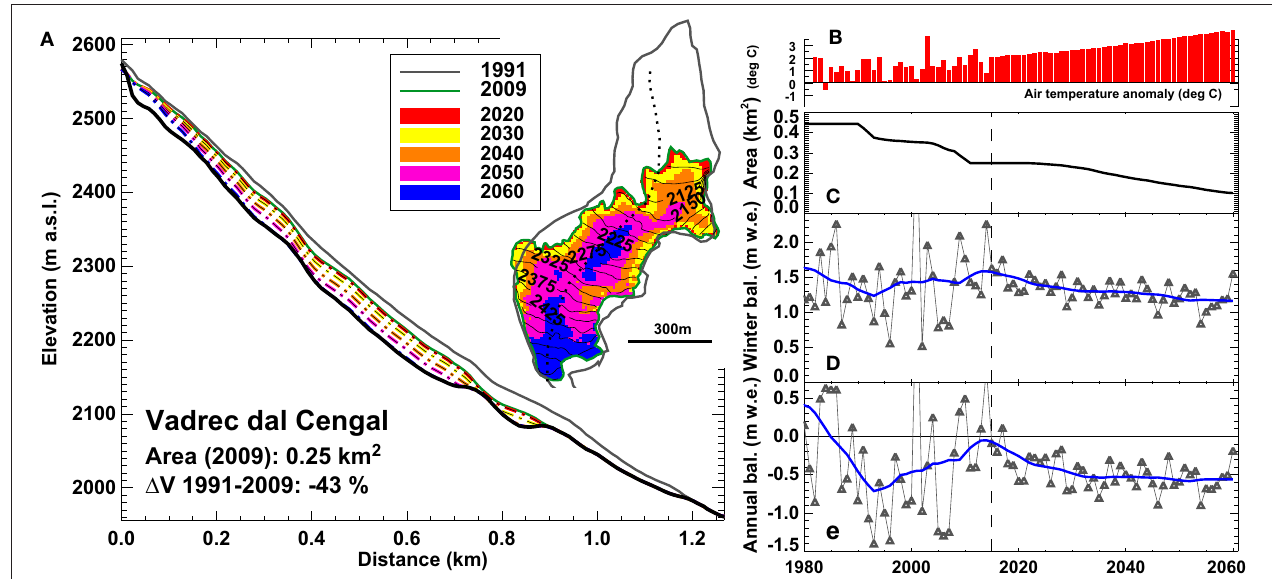
FIGURE 13 | Simulated future evolution of Vardec dal Cengal, South-Eastern Switzerland (A1B median scenario). (A) Longitudinal profile and past, current and future glacier extents, and time series of (B) air temperature anomaly, (C) glacier area, (D) winter mass balance, and (E) annual balance.